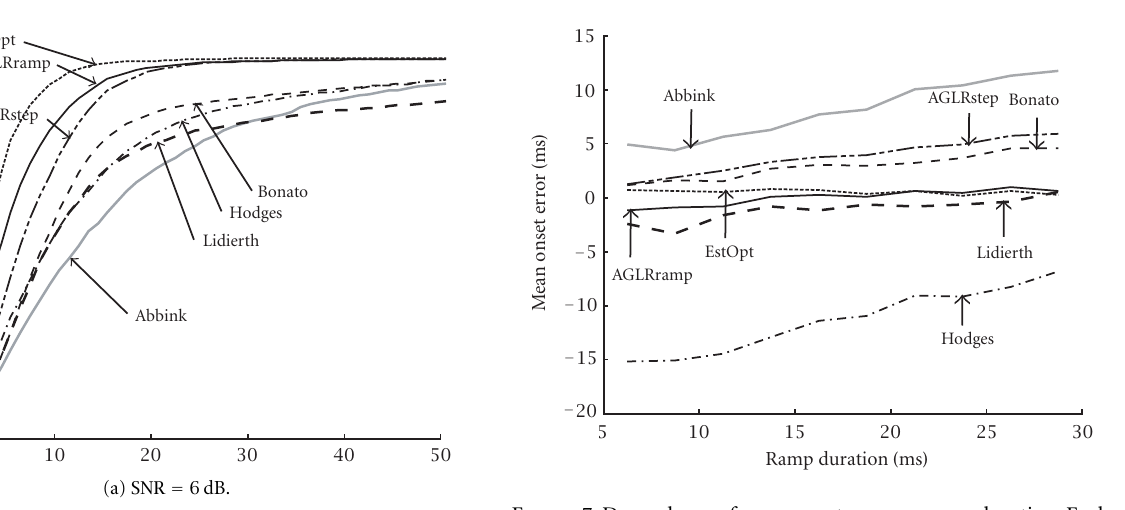
Figure 7: Dependence of mean onset error on ramp duration. Eval- uation of Mixed Ramp Trials data set (SNR of 10dB, ramp duration 5–30ms).